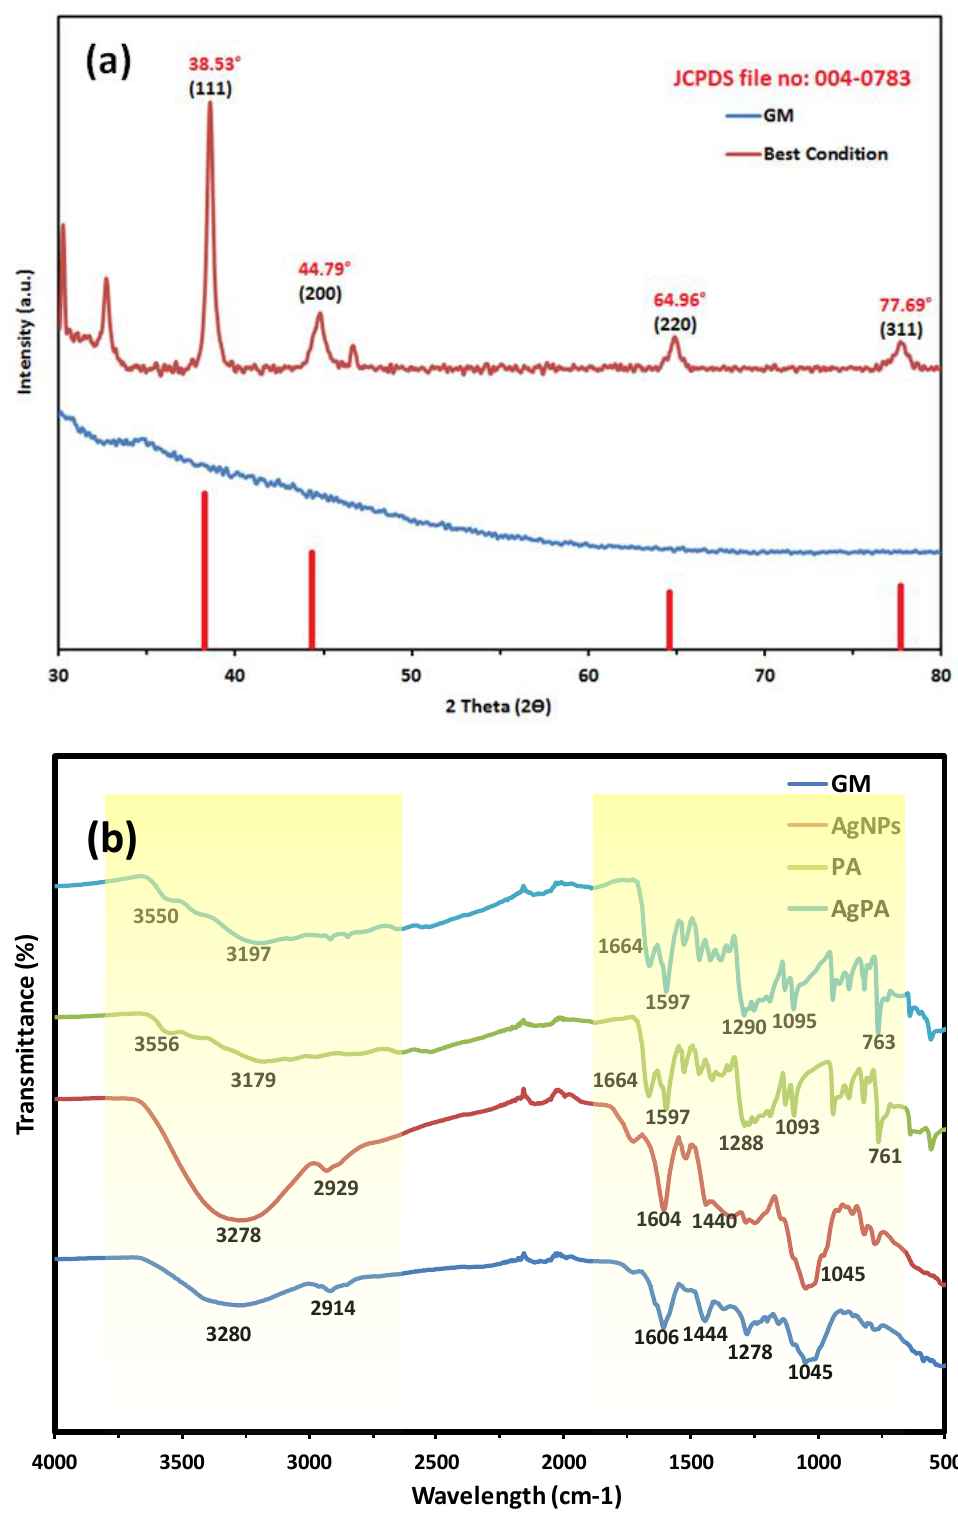
Figure 4. ( a ) XRD spectra of AgNPs and the intensity peak of reference data and ( b ) FTIR graphs of GM, AgNPs, PCA and AgPCA.